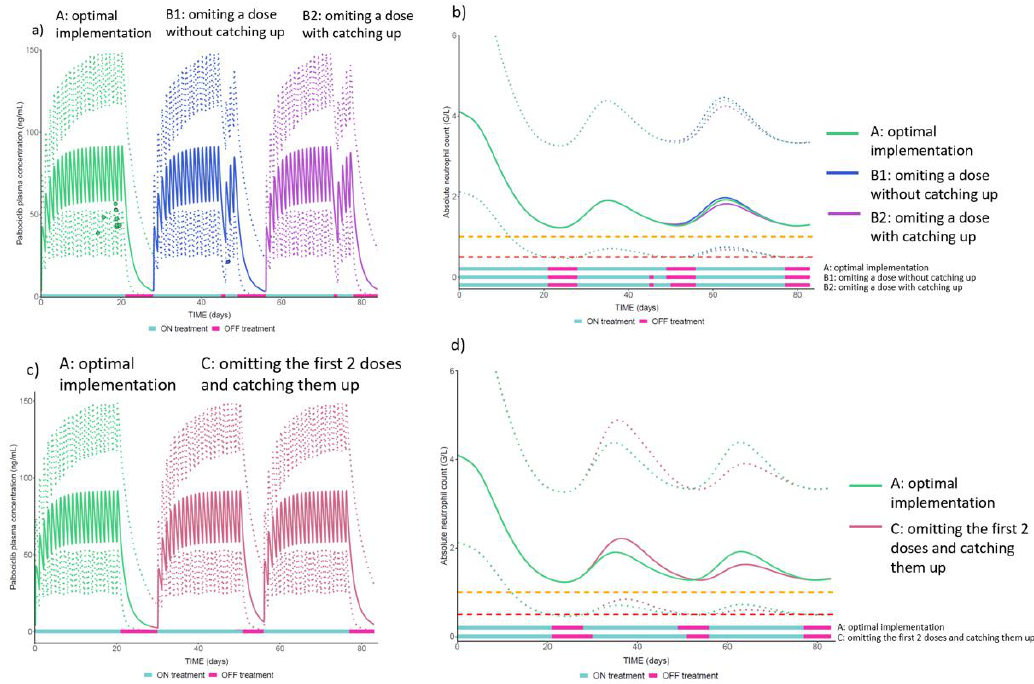
Figure 4. Population median prediction of palbociclib plasma concentrations profiles–solid lines in ( a , c )—and absolute neutrophil count–solid lines in ( b , d )—and their 95% prediction intervals–dotted lines. Orange and red dotted lines represent, respectively the threshold for neutropenia grade ≥3 and ≥4. NB: the dots in ( a ) represent the observed plasma palbociclib concentrations in a real patient included in the OpTAT study in both A and B1 scenarios. In scenario A, the concentrations are lower than the median observed in the simulated patients. This observation is consistent over this patient’s cycles and could be attributed to several extrinsic factors potentially increasing palbociclib elimination for this patient (e.g., co-administration of proton-pump inhibitors in fasting conditions [35], increase in creatinine clearance or decrease in alkaline phosphatase [36]).